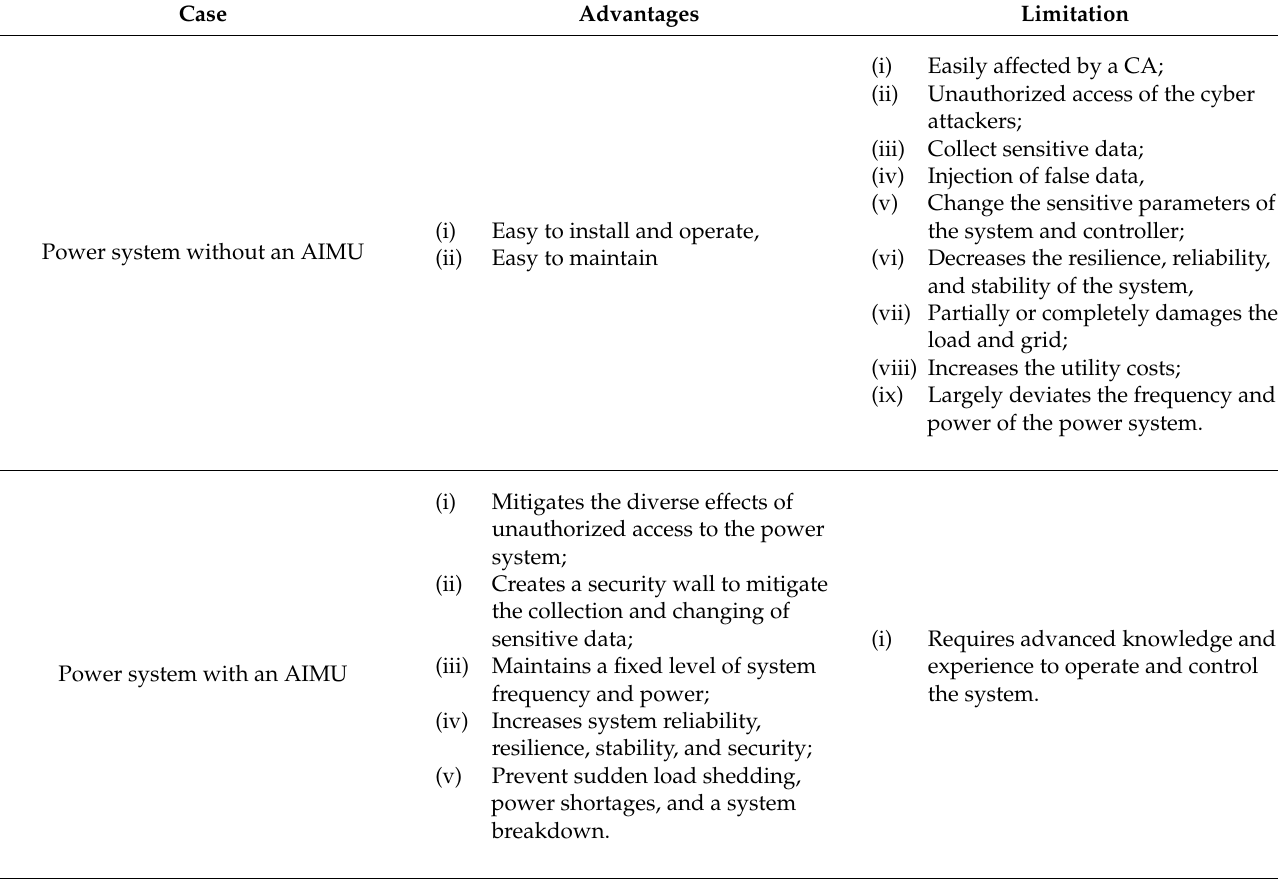
Table 7. Comparison of power systems based on an